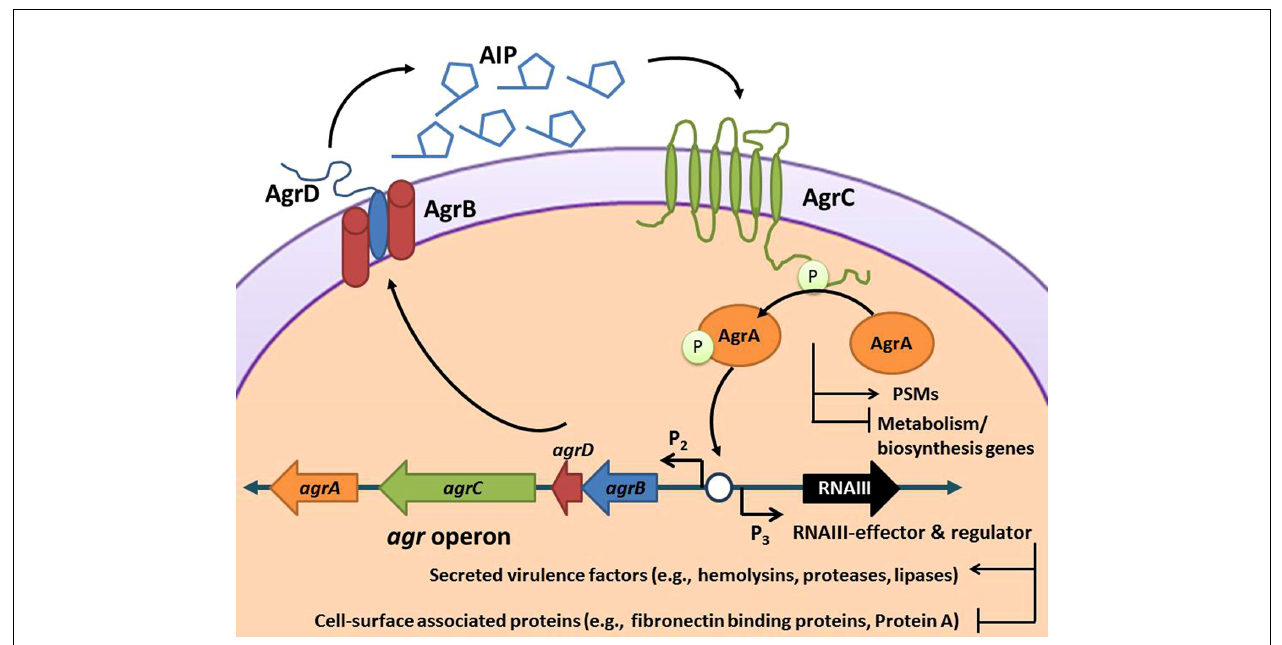
is activated by binding AIP, and AgrA is a response regulator that induces transcription of RNAII and RNAIII through the P2 and P3 promoters, respectively. AgrA also directly promotes PSM production.The RNAIII transcript yields a regulatory RNA molecule that acts as the primary effector of the agr system by up-regulating extracellular virulence factors and down-regulating cell surface proteins (Novick etal., 1993).